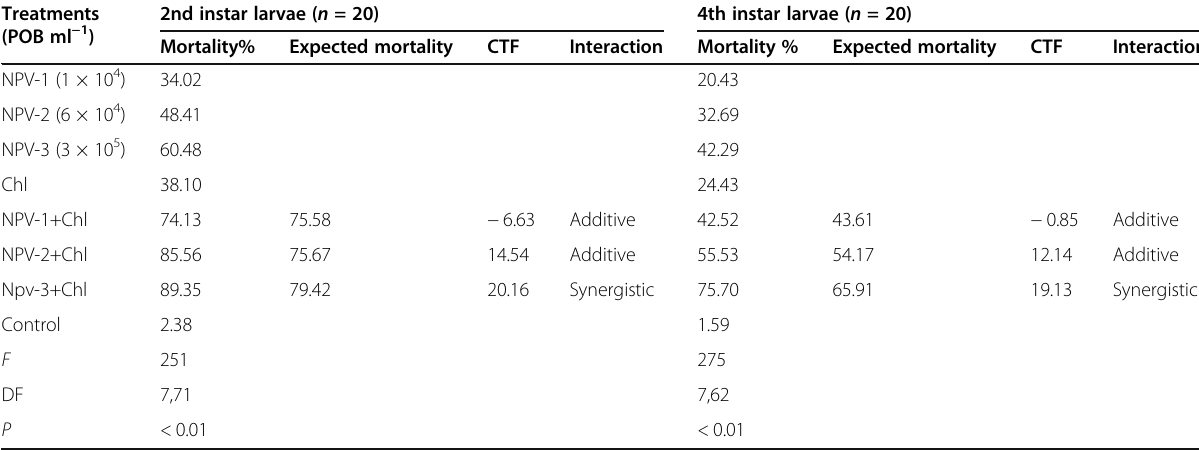
Table 1 Mortality percentage of the 2nd and 4th instars of Spodoptera litura larvae treated with nucleopolyhedrovirus alone and in combination with chlorantraniliprole 2nd instar larvae ( n = Treatments (POB ml − 1 )